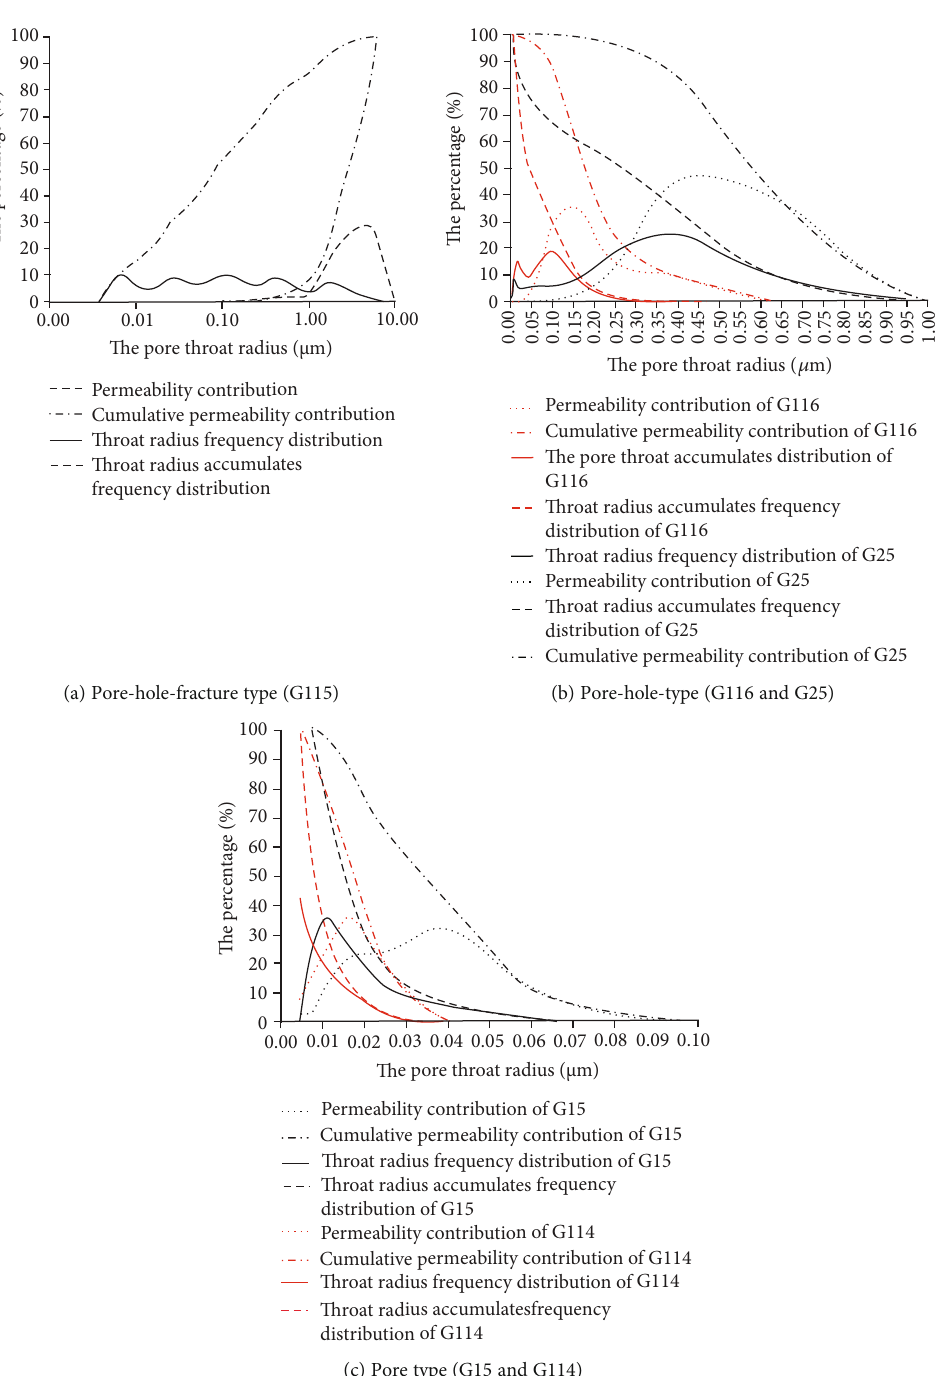
Figure 2: Pore throat radius distribution and permeability contribution of di ff erent types of